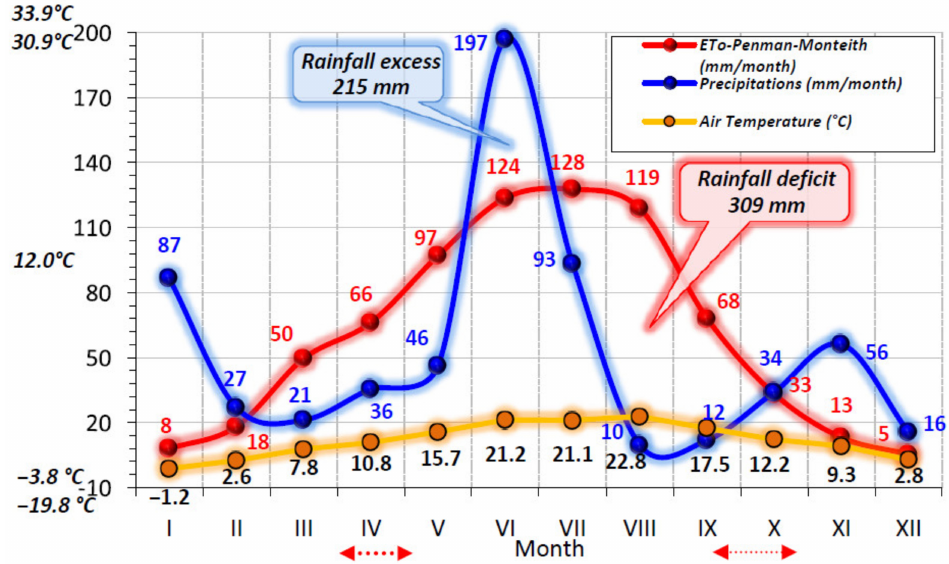
Figure 3. Meteorological data recorded in 2019 (monthly averages), potential evapotranspiration and the periods with the highest frequency of Phomopsis juglandina (red arrows) in the area of study (data obtained from the meteorological station of the Institute of Research and Development for Pomiculture